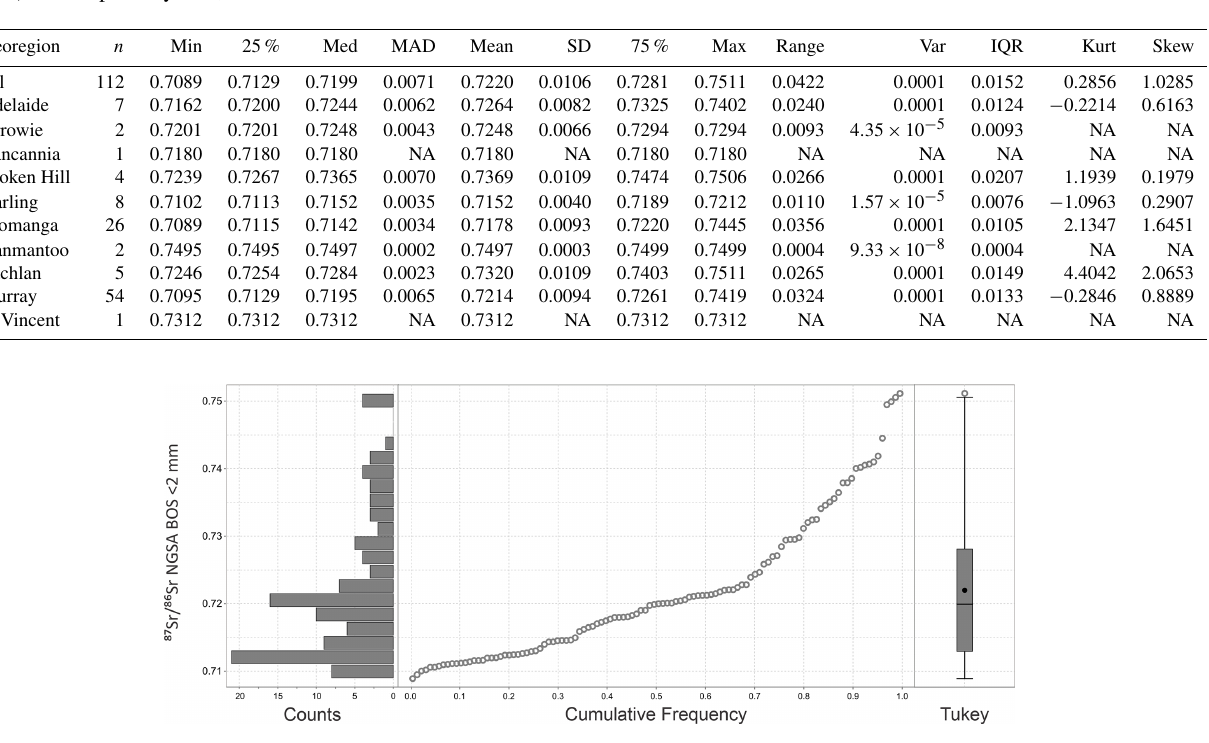
Table 1. Summary statistics (count, minimum, 25th percentile, median, median absolute deviation, mean, standard deviation, 75th percentile, maximum, range, variance, inter-quartile range, kurtosis, and skewness) of the 87 Sr / 86 Sr data from the Darling–Curnamona–Delamerian (DCD) Sr isotope study area, southeastern Australia. NA: not available.